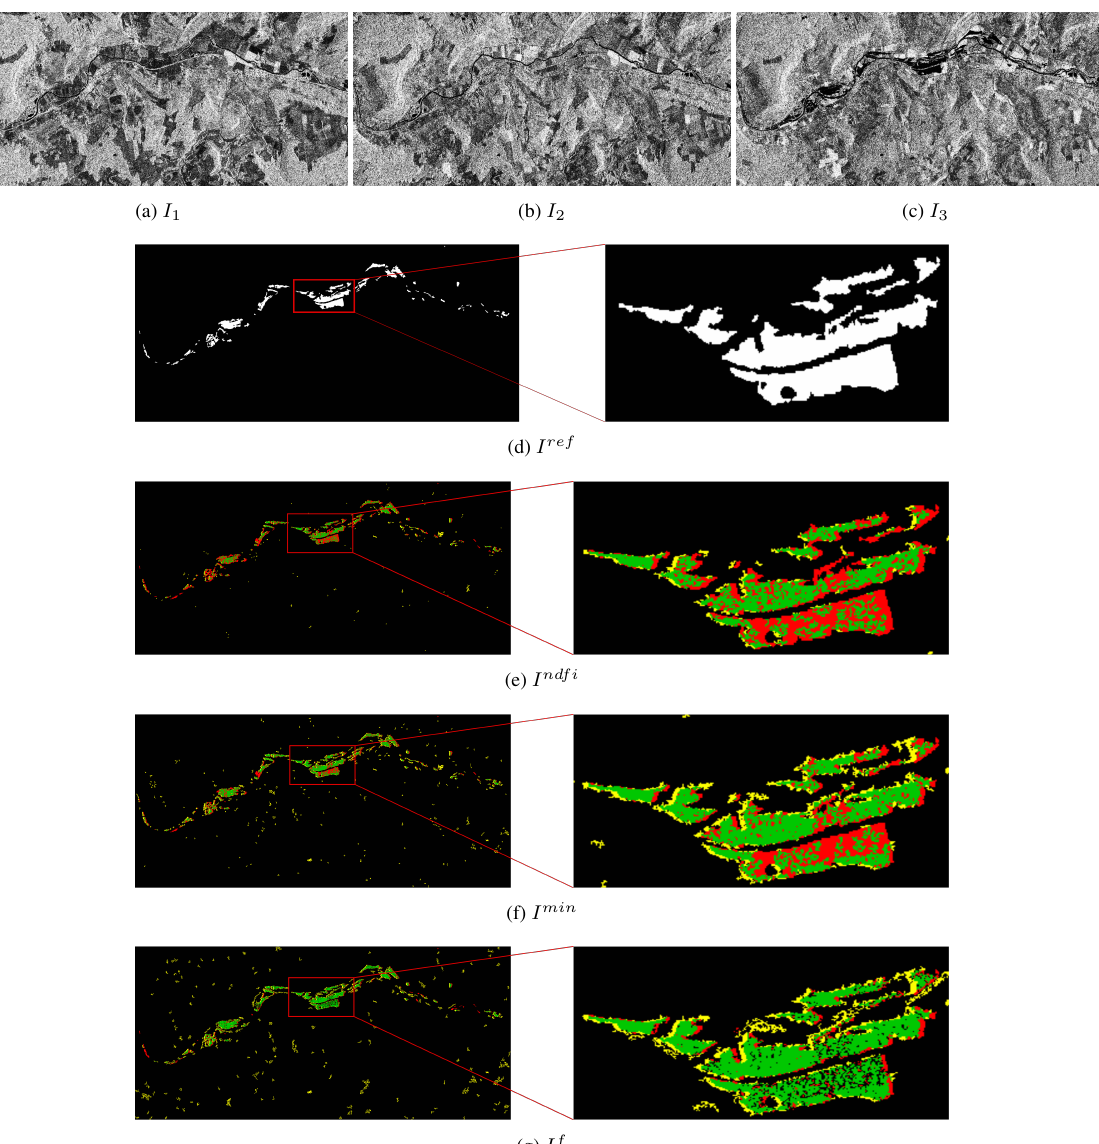
Figure 5. Flood Observation (from top to bottom): Original Sentinel-1 images (a)-(c); Reference image for flood (d); Results with NDFI (e), the min-tree threshold analysis (f), and our method (g). Results are given in green, red, and yellow for TP, FN, and FP